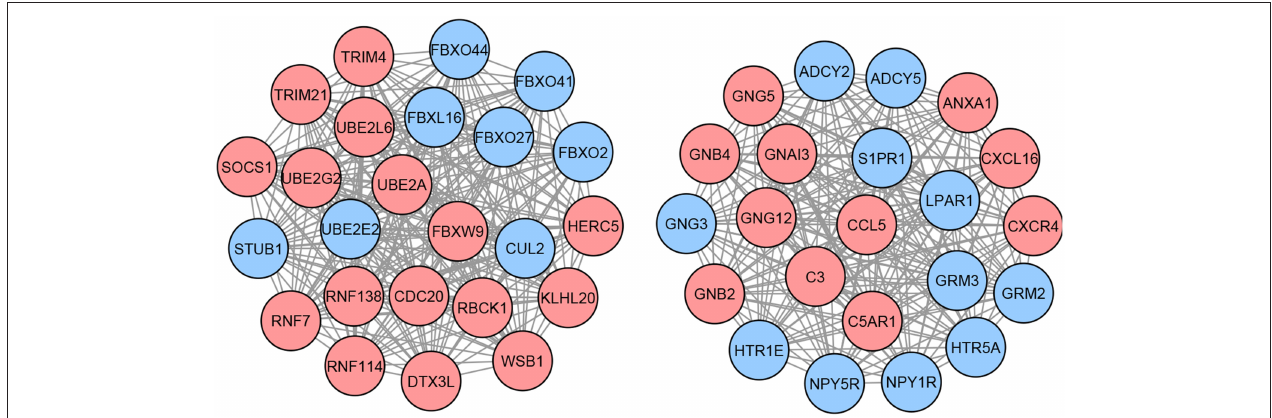
FIGURE 2 | Proposed network-based signature for GBM, containing a total of 46 genes organized in two different cliques. Each node in this graph represents a gene, while each edge describes the interaction between a gene pair. The interactions are retrieved from the STRING database. The colors of the nodes represent the effect sizes obtained from the meta-analysis step described in Figure 1A : red represents genes with a positive effect size while blue represents genes with a negative effect size.